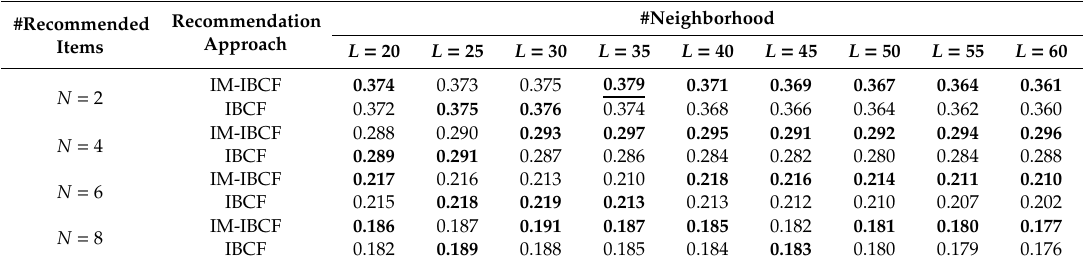
Table 8. Results of precision measure on the MovieLens 1M dataset.